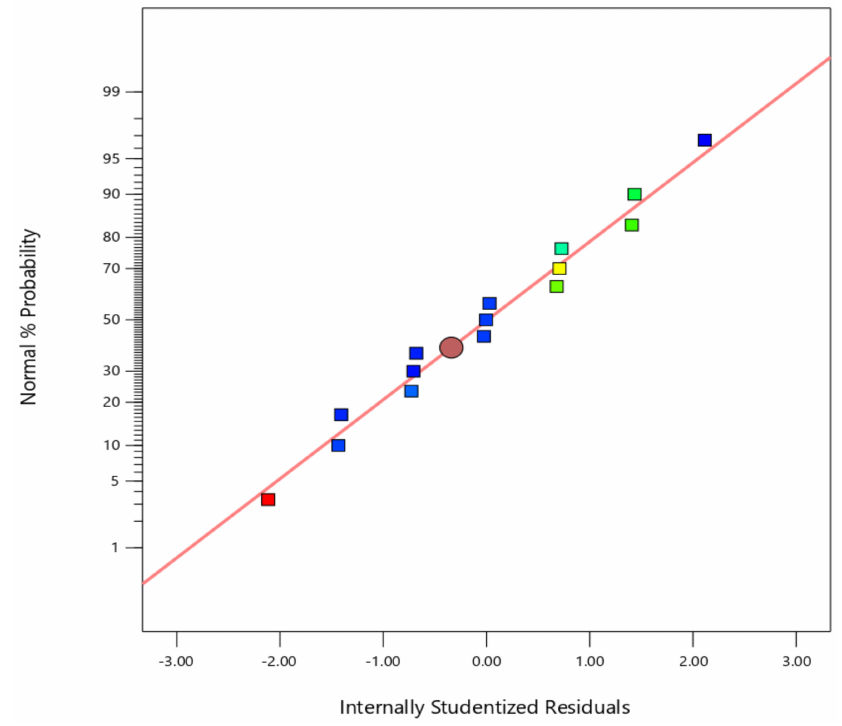
Figure 4. Normal probability plot of internally studentized residuals.